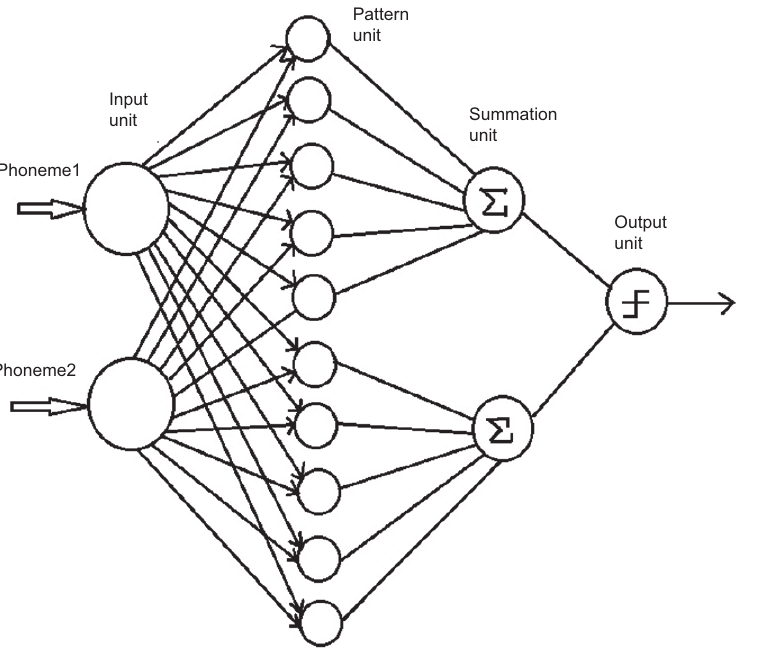
Figure 2. Structure of